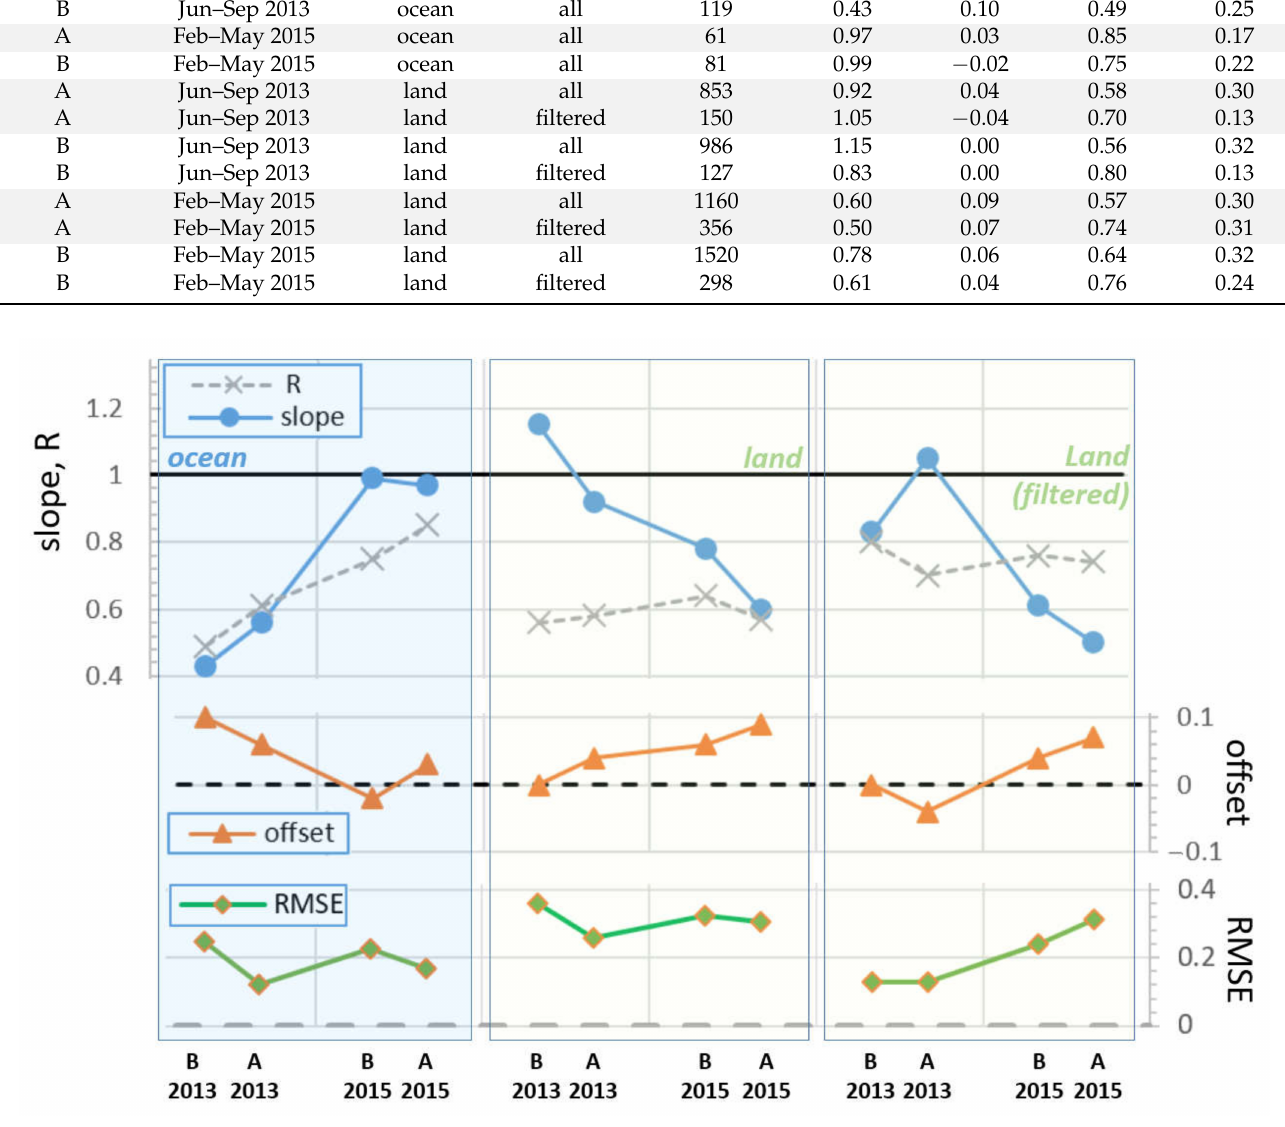
Figure 10. Performance of PMAp based on the matchups with AERONET measurements for Metop- A, -B, for the two reference periods in 2013 and 2015, and over the ocean (left) and land (middle) and land in the case of filtered data (right). Values for slope, R , offset, and RMSE is taken from Table 6. The black plain and dashed lines represent the perfect performance with slope/R equal to 1 (plain) and offset/ RMSE equal to 0